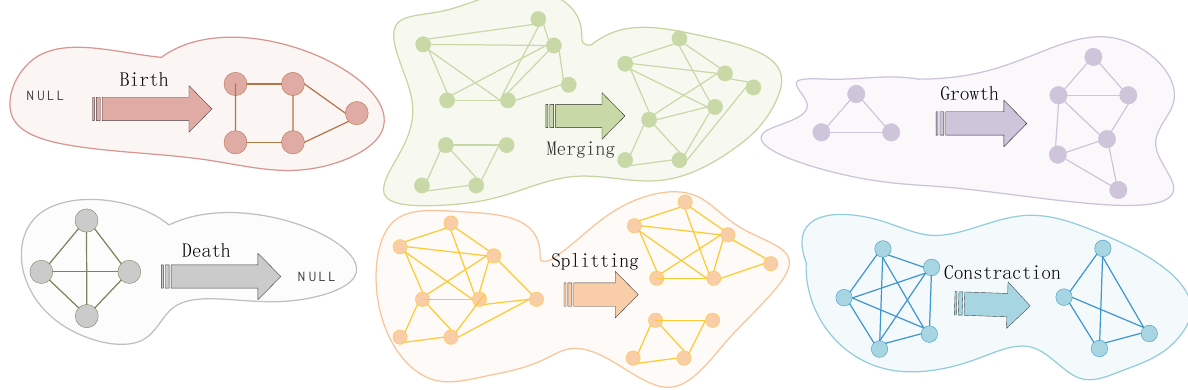
Figure 1. 6 evolutionary events in dynamic communities.